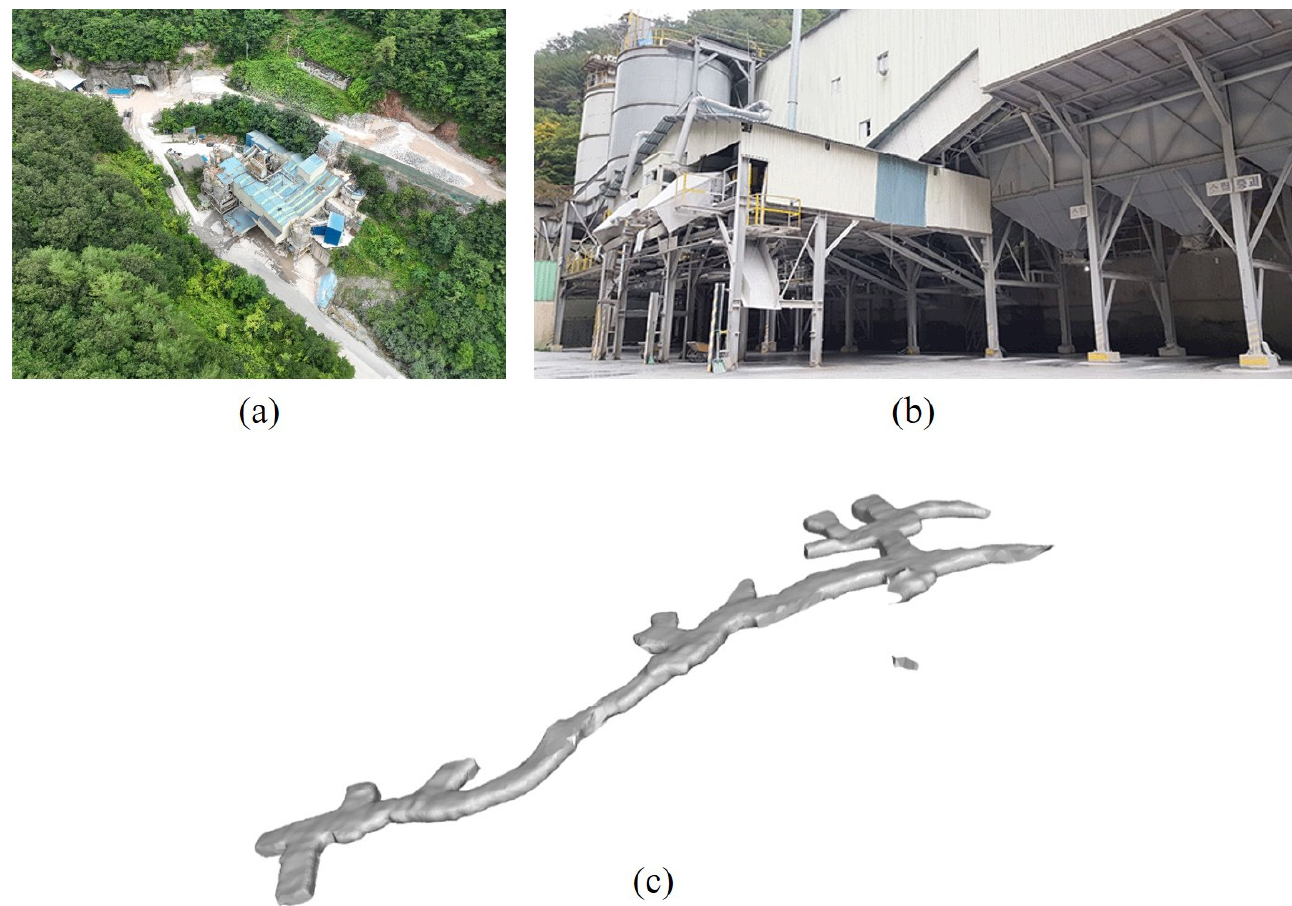
Figure 1. Taeyoung EMC Samdo Mine. ( a ) Panoramic view, ( b ) mineral processing facility, and ( c ) 3D map of underground mine.